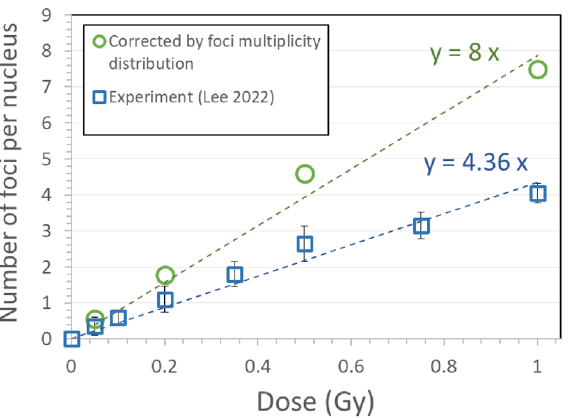
Figure 8. Mean number of γ-H2AX foci per nucleus in BEAS-2B cells exposed to alpha particles: as observed in experiments by Lee et al. 15 (squares) and corrected by utilizing the multiplicity distribution of γ-H2AX foci in a single focal image